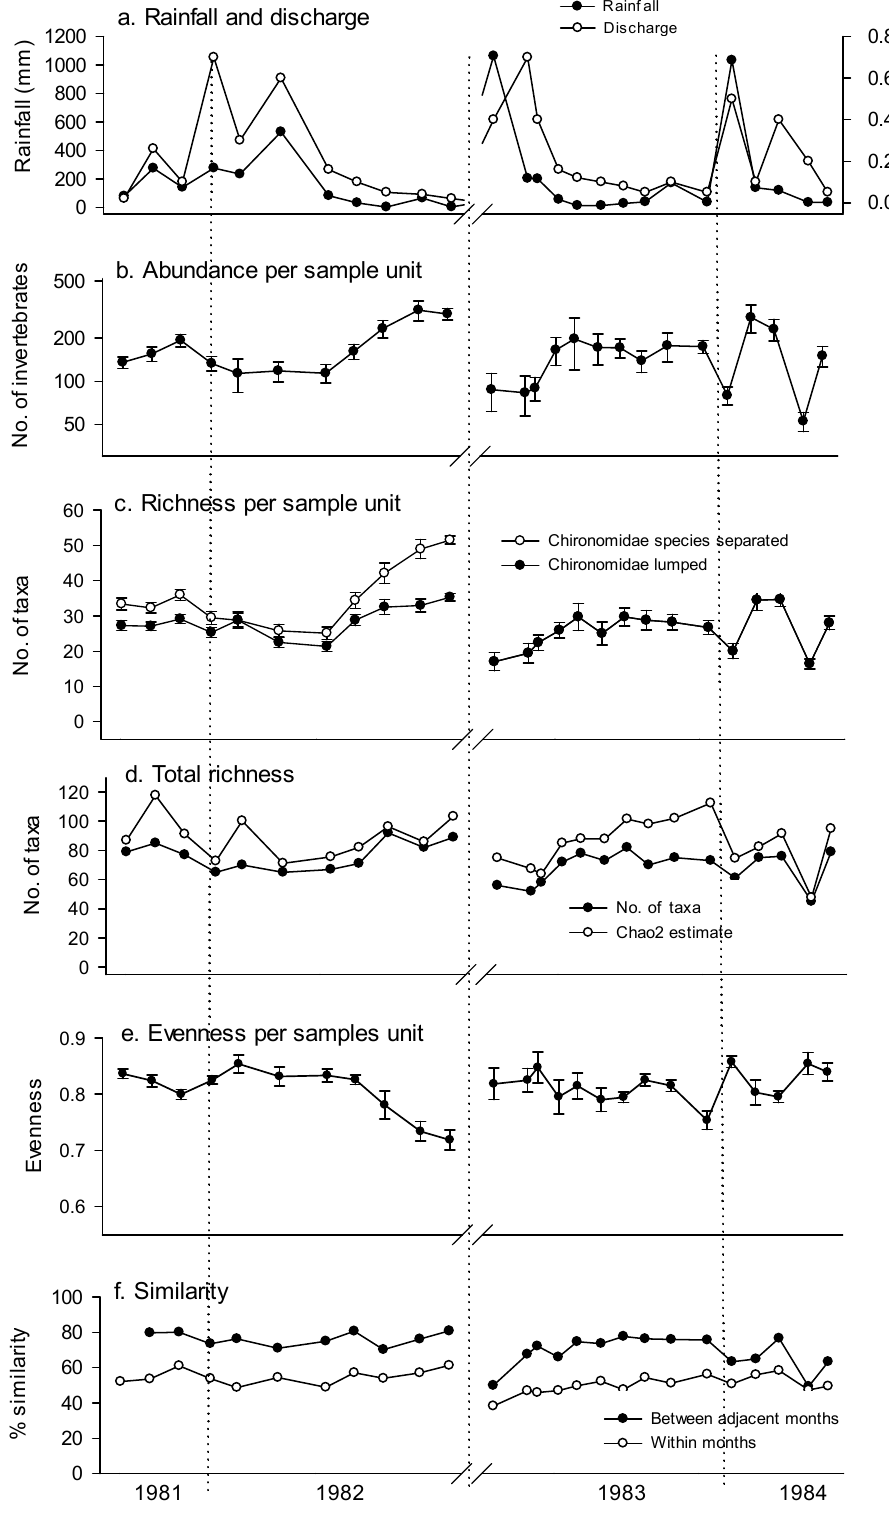
Figure 1. Monthly changes in rainfall, flow and invertebrate community metrics (± s.e. where appropriate) in Yuccabine Creek. Dotted vertical lines indicate January of each year. The break in the X axis indicates cessation of surface flow